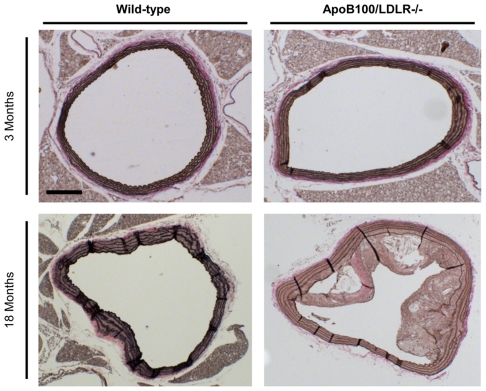
Structure of the thoracic aorta of young and aged wild-type and transgenic mice.Six sections (stained with Van Gieson stain) from different areas of the aorta were evaluated by two blinded observers, scoring for the deterioration of the elastic fibres in the media layer. The absence or presence of atheroma plaque was also independently examined. Scale bar: 100 µm.